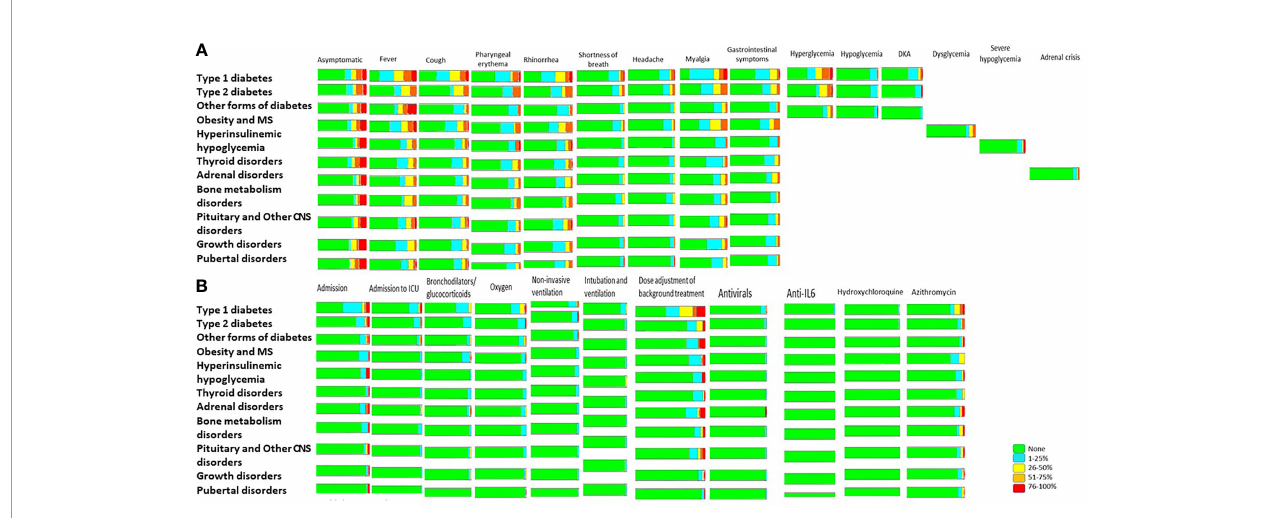
FIGURE 1 | Proportion of general and speci fi c symptomatology (A) and requirement for speci fi c therapeutic management (B) in COVID-19 patients attending pediatric endocrine centers. MS, metabolic syndrome; CNS, central nervous system; DKA, Diabetic ketoacidosis; ICU, Intensive Care Unit; IL-6,